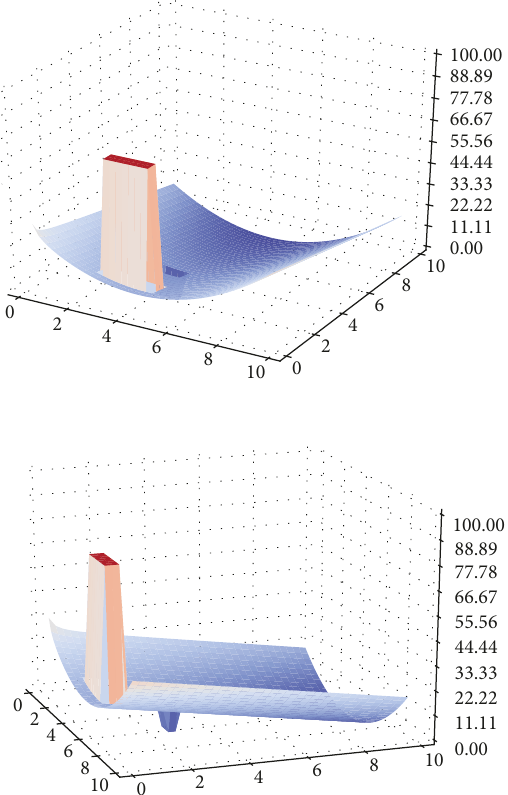
Figure 3: Two views of the complex surface to be minimized in simulation